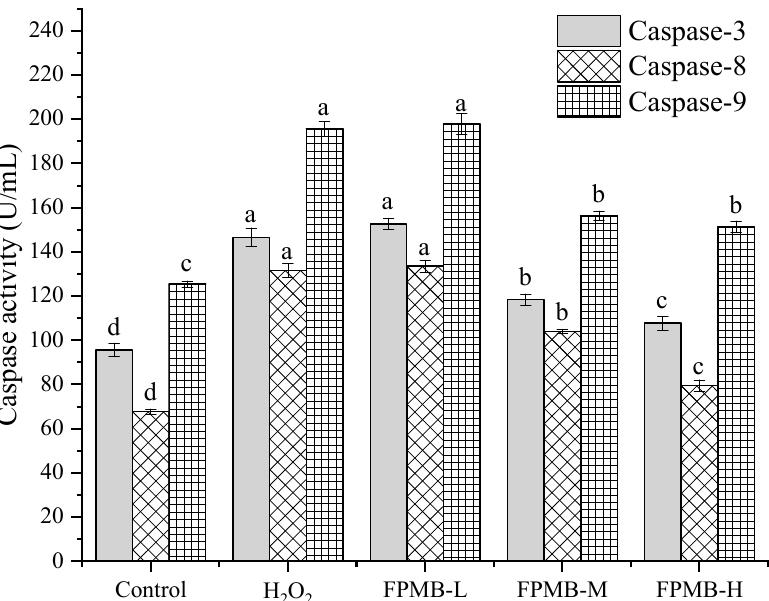
Figure 4. Effect of FPMB on the activity of caspase-3, caspase-8, and caspase-9 in mice cardiomyocytes injured by H 2 O 2 . Different lowercase letters (a, b, c, d) in the same caspase express significant differences ( p < 0.05).